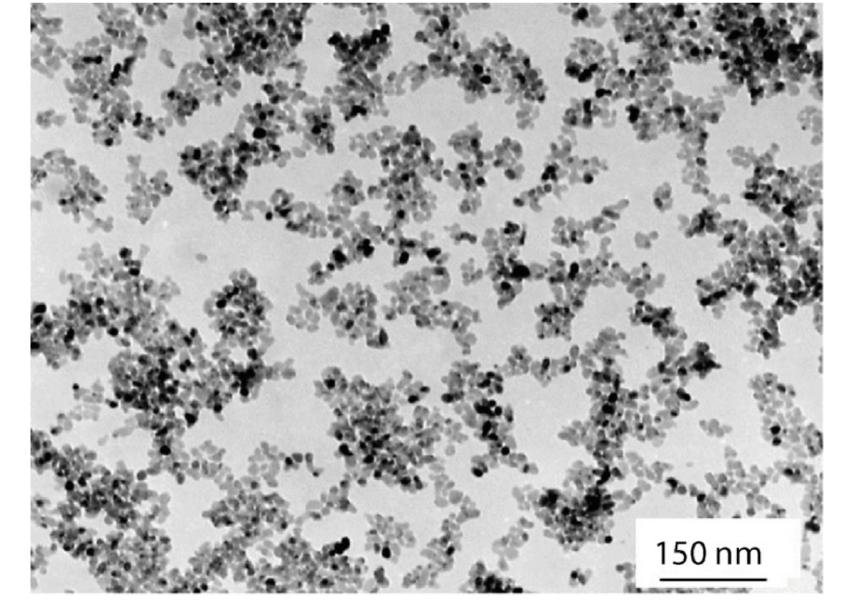
Figure 1. TEM image of a nanopowder with the composition ZrO 2 + 3 mol% Y 2 O 3 , 400 ◦ C, 2 h. It can be seen that the particles of the order of 9 nm are uniform in size and relatively well separated.